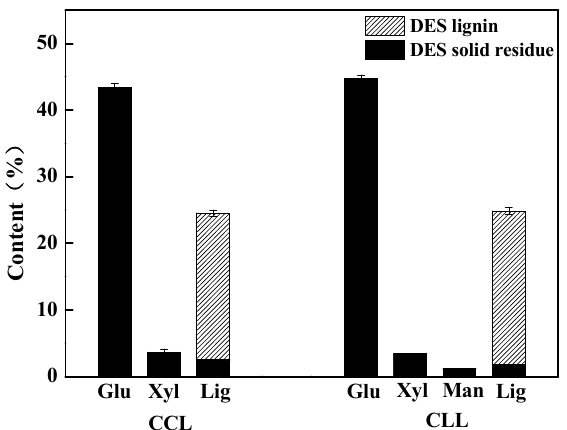
Figure 2. Composition analysis of samples in DES-treated solid residue and DES lignin at 140 °C for 12 h. (Based on over-dry basis of the initial sample).